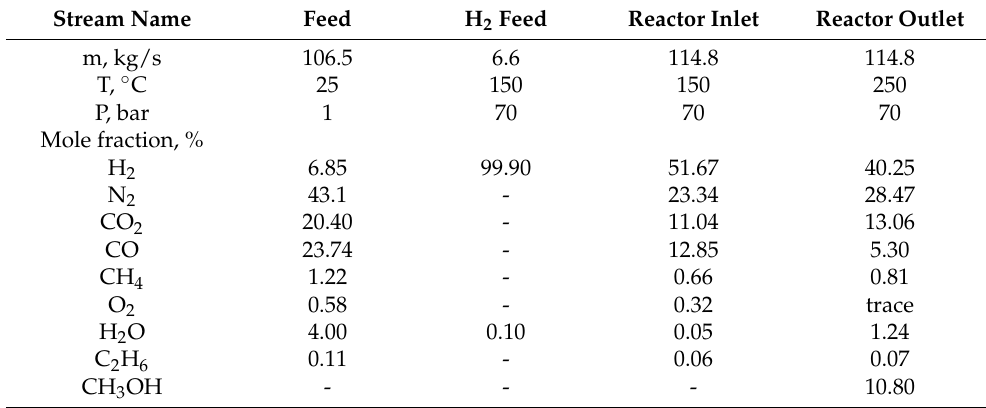
Table A2. Stream results of the MeOH case.